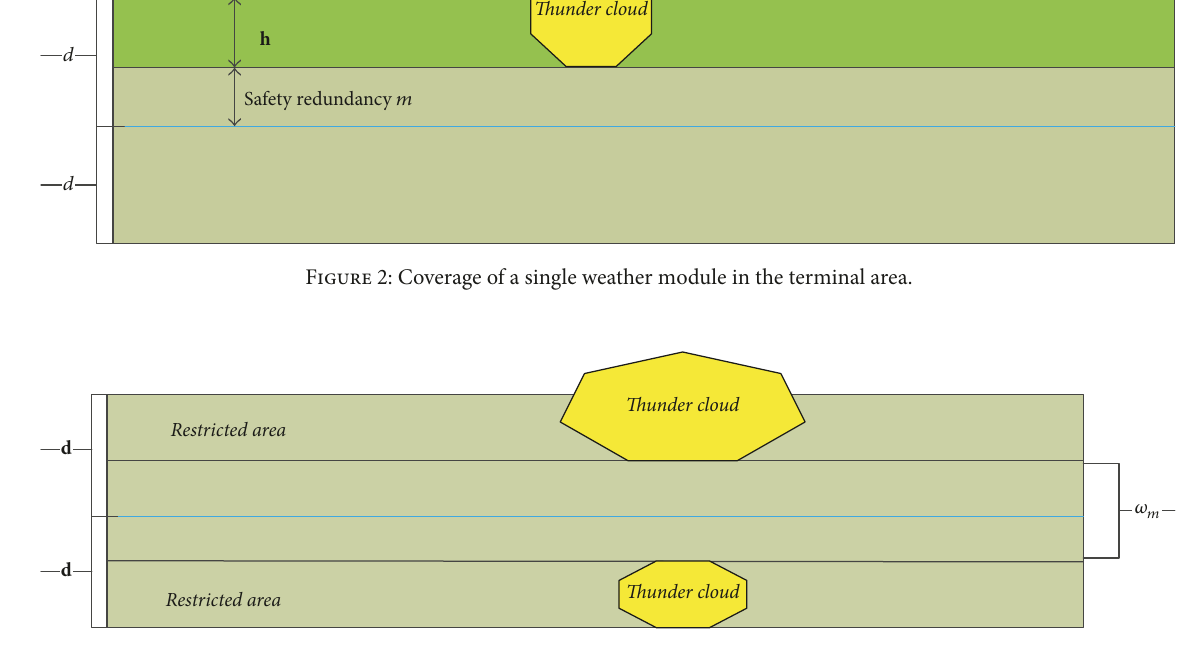
Figure 3: Route coverage of a linear weather module in a terminal